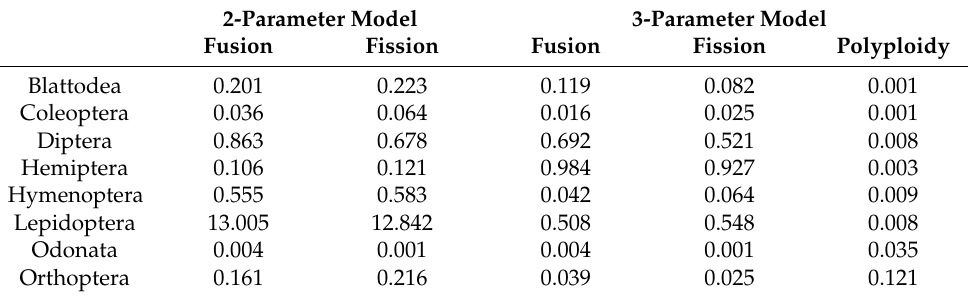
Table 1. Rate estimates for included insect